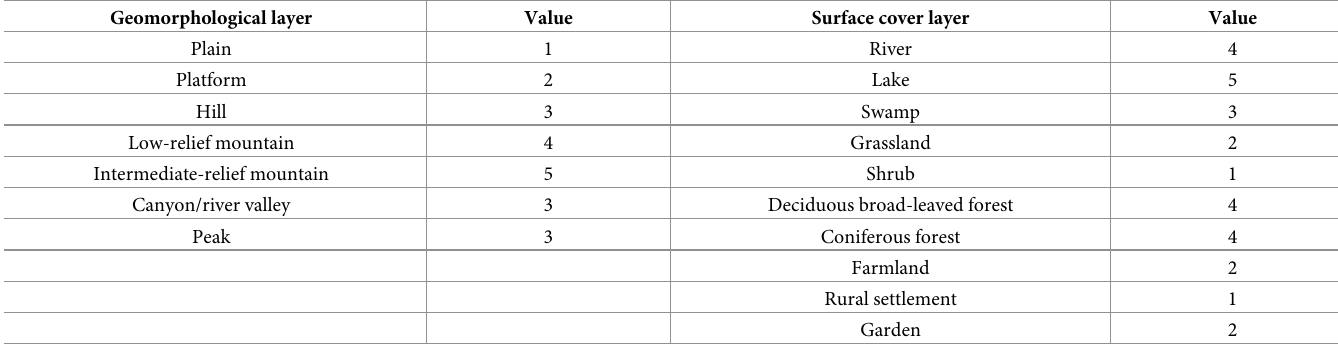
Table 8. Scoring table of experts on the value of scenic